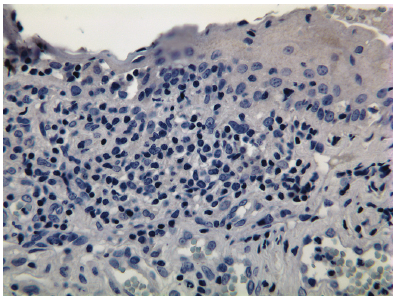
Figure 5: The lymphocytes are negative for CD20 (left conjunctiva, immunoperoxidase staining,